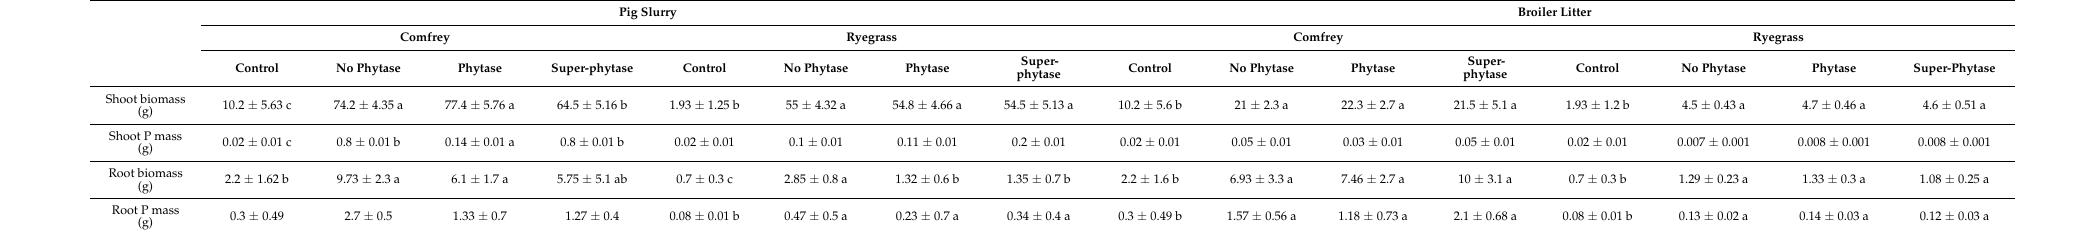
Table 2. Effects of two different organic amendments (pig slurry and broiler litter) from different animal diets on plant aboveground biomass (shoot biomass, grams), shoot P mass (grams of P), plant belowground biomass (root biomass, grams) and root P mass (grams of P) of two different plant species comfrey ( Symphytum × uplandicum ) and Italian ryegrass ( Lolium multiflorum ). Animal diets include: control = only inorganic fertiliser applied once (i.e., one dose of triple super P initially applied to support seedling growth), no-phytase, phytase and superdose phytase. Different letters indicate significant differences among treatments (Tukey HSD